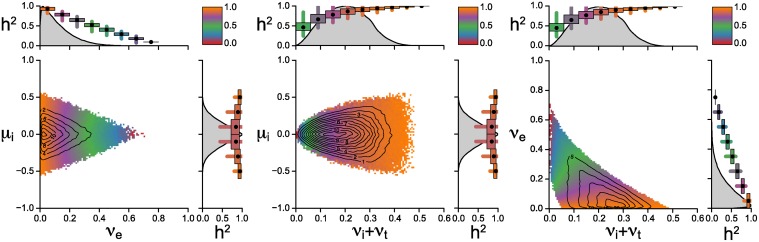
Posterior distribution of parameters from the rejection sampler.We report pairwise scatterplots of the parameters μ
i, ν
e and the compound parameter ν
i + ν
t, since these two parameters only appear as a sum in all equations for the mean, variance and heritability. 107 random sets of parameter values are sampled randomly from the uniform priors described by the ranges on the x and y axes. Around 1.9% of the randomly generated parameter combinations yield values for mean and variance of log spVL that are compatible with the acceptance criterion 4 < M̃
C < 5, 0.3 < Ṽ
C < 0.8. The contour lines show the two-dimensional kernel density estimate of the posterior sample. The colours reflect the mean heritability of binned parameter combinations and are stacked such that points with lower heritability lie on top of points with higher heritability. The small plots to the top and right of the scatterplots show the posterior density estimate along a single parameter dimension, as well as the mean (black dot), and 50% (boxes) and 95% quantiles (lines) of heritabilities along those parameter dimensions. Most of the probability mass occurs at low values of μ
i and ν
e.